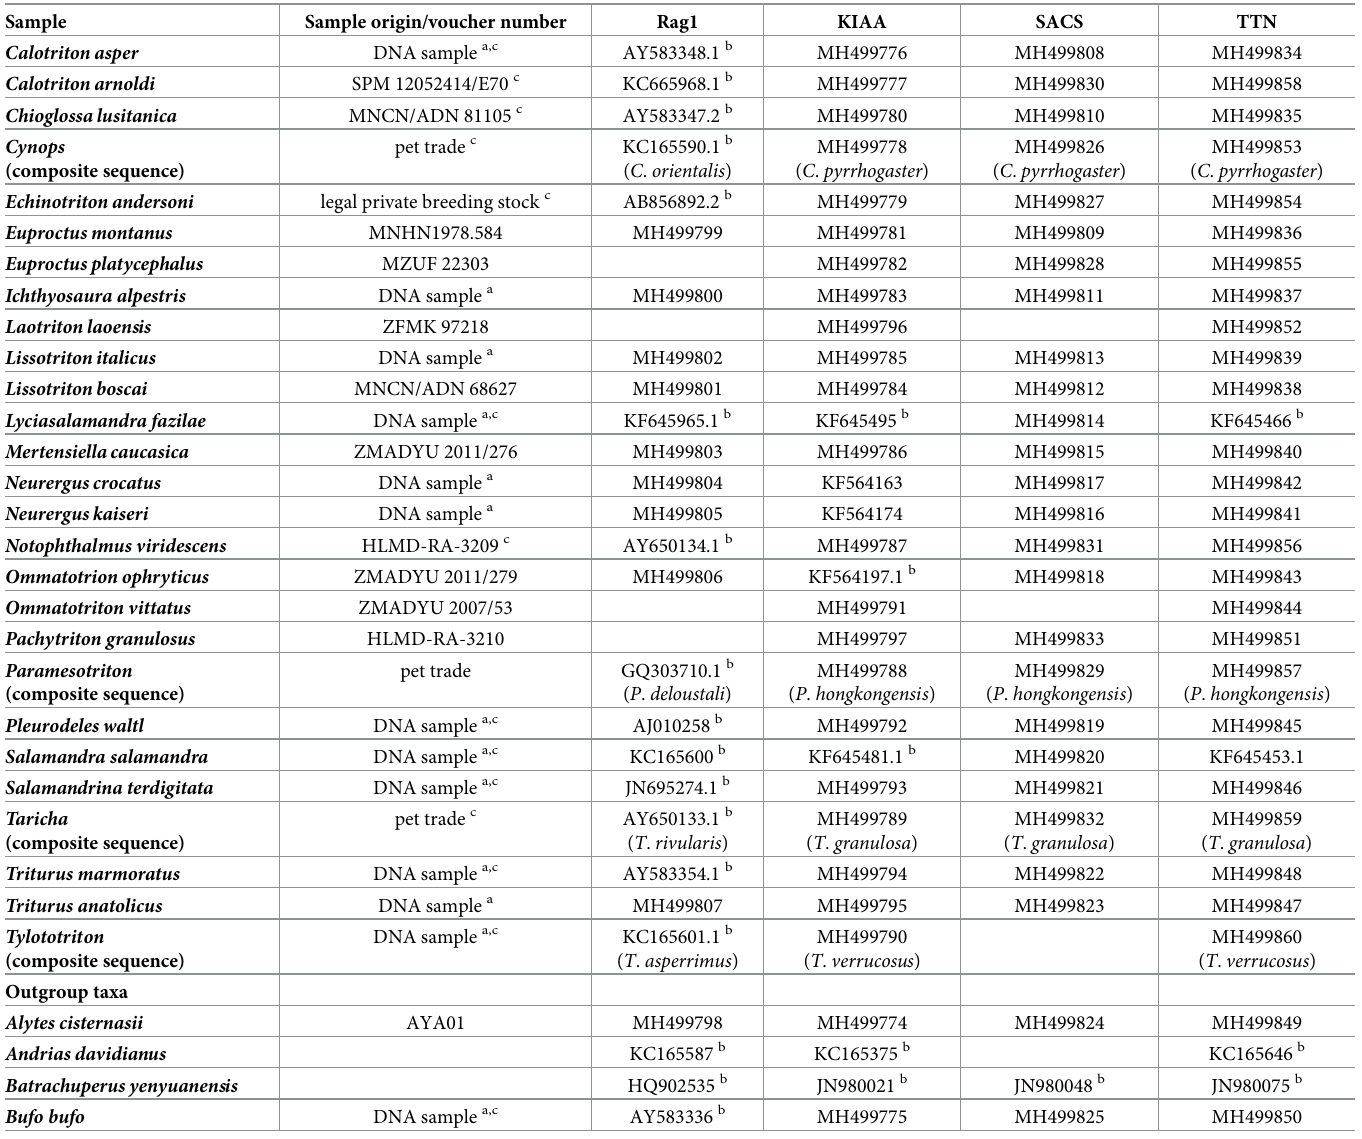
Table 1. Samples analyzed for fragments of RAG1, KIAA, SACS and